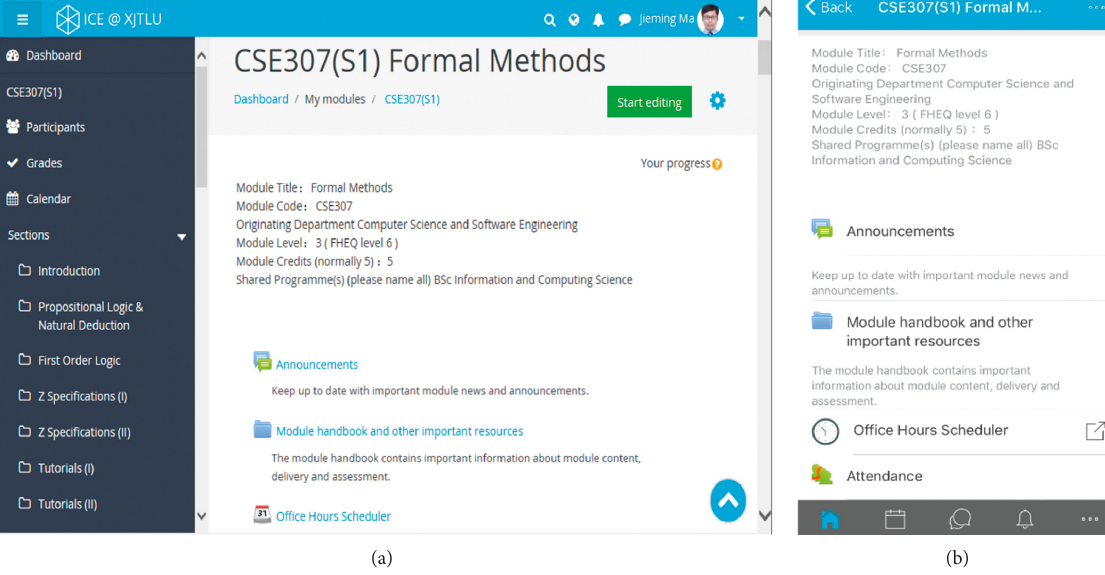
Figure 3: ICE interface: (a) website and (b)